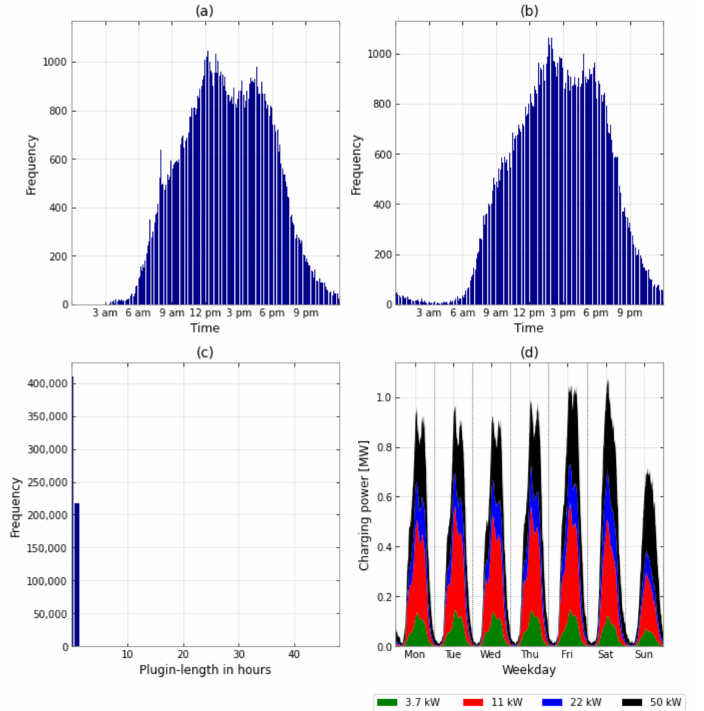
Figure A8. Charging characteristics of temporal charging cluster 6: ( a ) Frequency of different plug-in times; ( b ) Frequency of different plug-out times; ( c ) Frequency of different plug-in lengths; ( d ) Charging power